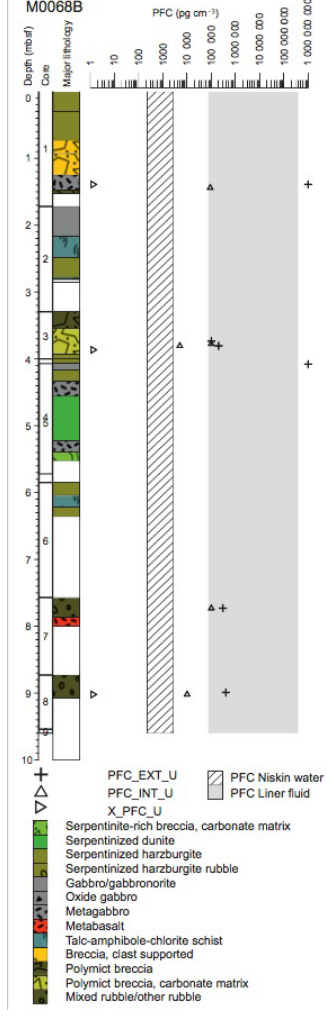
Figure 4. Summary of PFC tracer concentrations (in pgcm − 3 on logarithmic scale) in samples collected during IODP Expedi- tion 357 from Hole M0068B, as compared to the lithology logs from the site according to legend (Früh-Green et al., 2017a). For this figure (and all figures in the Supplement), symbols are as fol- lows. PFC concentrations measured in fluid samples from the sen- sor package Niskin bottles (“PFC Niskin water”, grey shaded box) and the core liner fluids (“PFC Liner fluid”, match mark box) pre- sented as the range of lower and upper concentrations measured in samples from each hole. PFC concentrations measured on whole- round core (WRC) samples: PFC_EXT_U (cross), exterior piece of unflamed whole-round core sample (WRC); PFC_INT_U (tri- angle), interior piece of unflamed WRC; X_PFC_U (arrow), ho- mogenized unflamed WRC after serial rinsing with ultrapure water; PFC_EXT_F (circle), exterior piece of flamed WRC; PFC_INT_F (diamond), interior piece of flamed WRC; X_PFC_F (star), homog- enized flamed WRC after serial rinsing with ultrapure water. Values on right-most edge of axis represent values above the maximum de- tection limit (>1mgcm − 3 ), and values on left-most edge of axis represent values below the minimum detection limit (as shown in Table